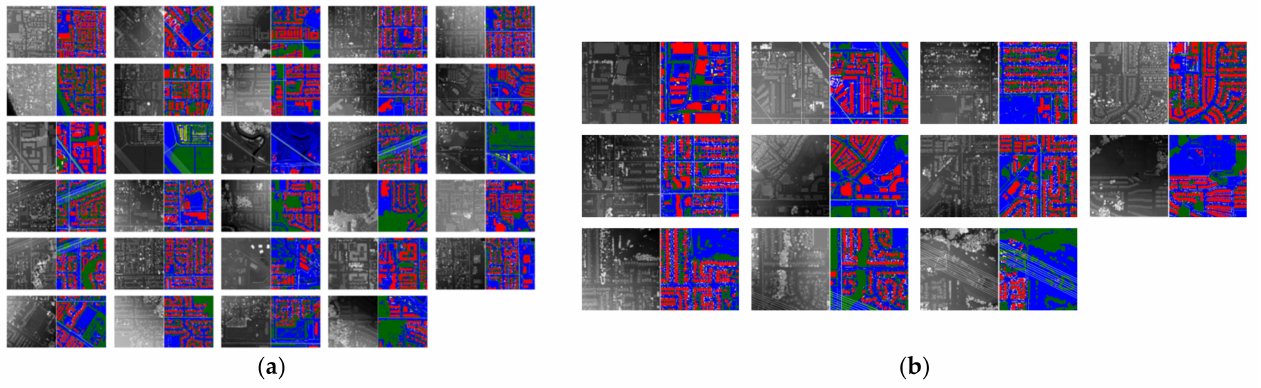
Figure 2. Location of data tiles overlaid on Google Earth image (yellow and red box represent training and test datasets, respectively).